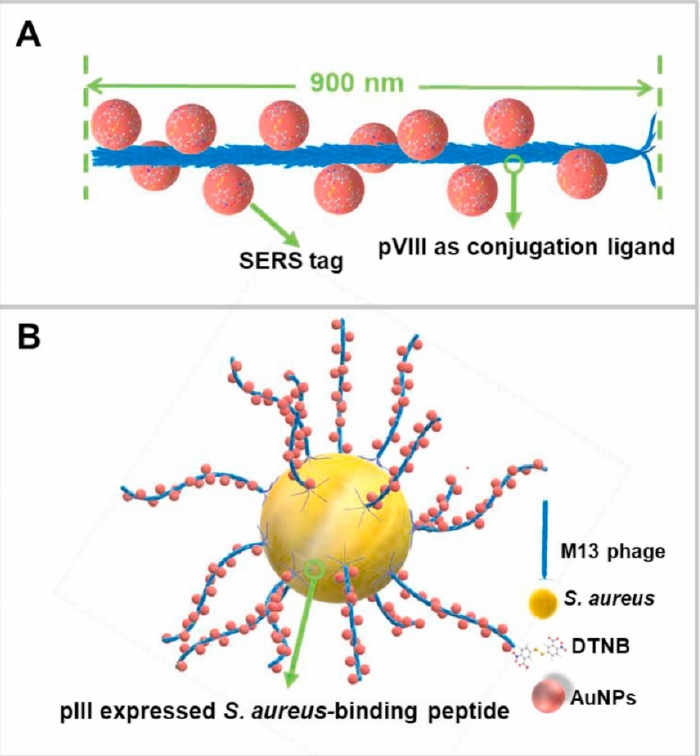
Figure 12. ( A ) Depiction of M13-SERS probe and ( B ) M13-SERS probe capturing S. aureus. The pVIII protein acts as conjugation ligand for the in situ growth of gold nanoparticles. The pIII protein is genetically engineered for selecting specific peptides. Reproduced with permission from [89]. Cop-